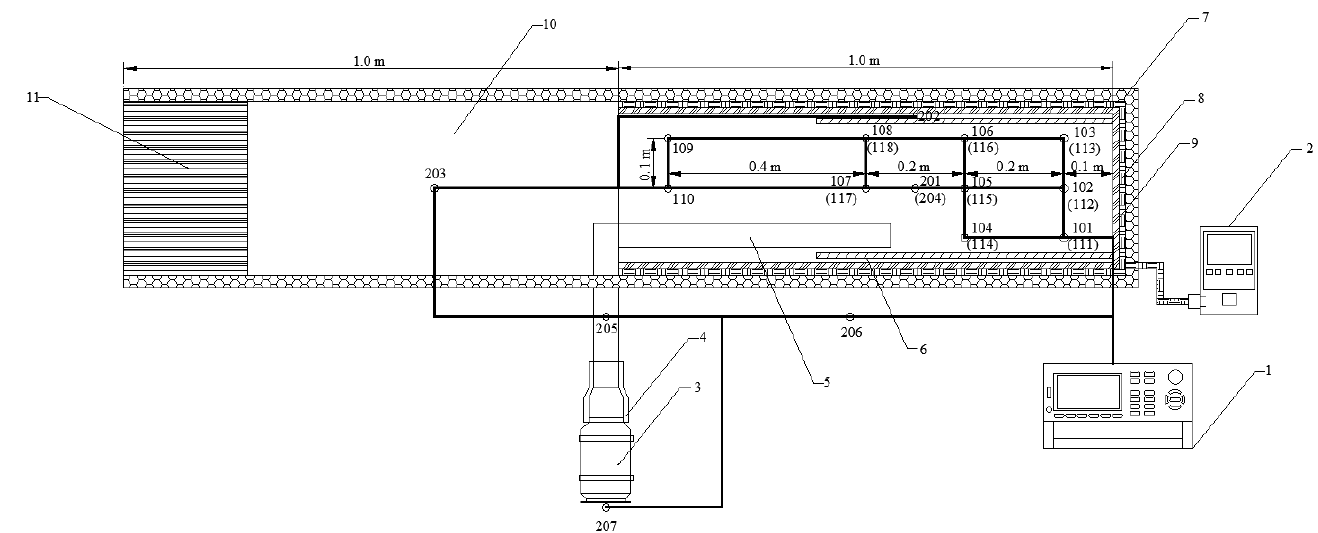
Figure 3. Distribution of temperature-monitoring locations on the test platform. 1 — Data acquisition system; 2 — Temperature controller; 3 — Axial fan; 4 — Reducer; 5 — Ventilation duct; 6 — Partial thermal insulation baffle; 7 — Insulation cotton; 8 — Electric heating belt; 9 — Surrounding rock; 10 — Virtual tunnel; 11 — Tunnel movable exit. Table 6. Temperature variation in the test